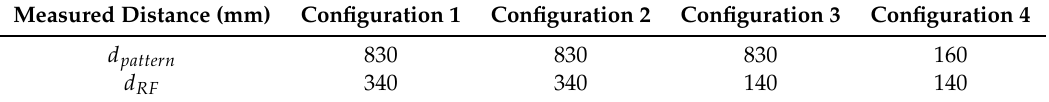
Table 1. The calibration distances d RF and d pattern for the four configurations in Figure